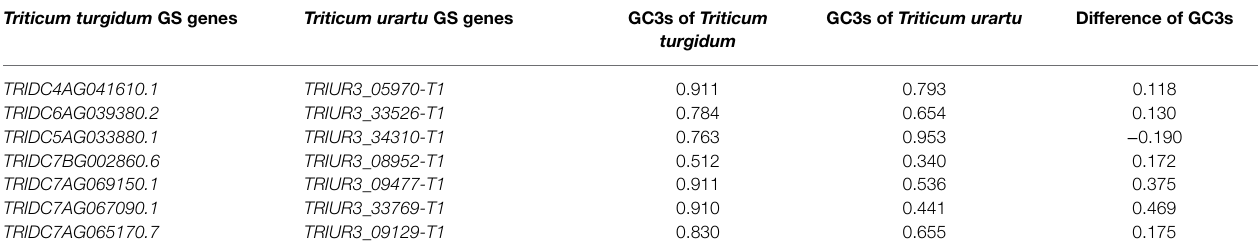
TABLE 2 | The GC3s variation of grain size genes during polyploidization with Triticum turgidum and Triticum urartu .